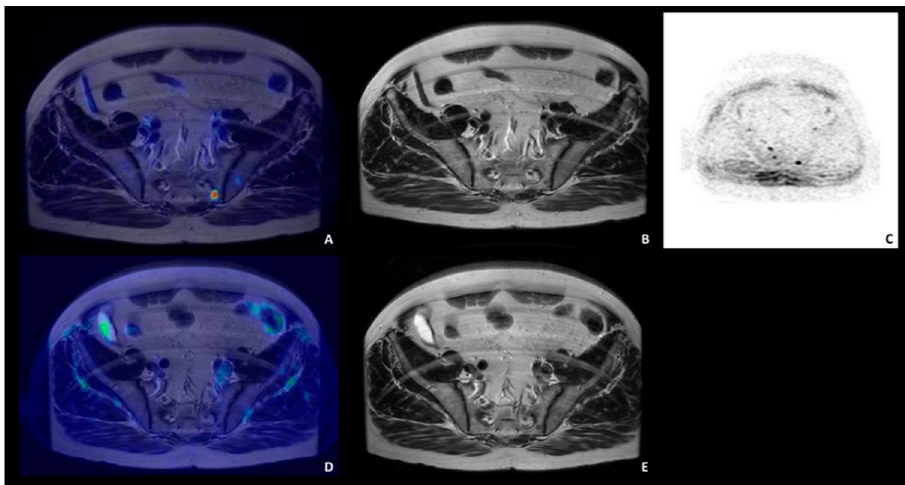
Figure 5. A 59 years-old patient with biopsy-proven PCa (patient n. 6), Gleason score 9 (4 + 5) with a PSA level at diagnosis of 11.0 ng/mL. 68 Ga-PSMA PET/MRI (top panel; ( A ): 68 Ga-PSMA PET/MRI; ( B ): axial T2-weighted sequence of the pelvis; ( C ): axial DWI (b = 1000) displayed with inverted greyscale map) showed increased uptake in correspondence of the left sacral ala, where MRI detected a bone metastasis; 68 Ga-DOTA-RM2 PET/MRI (bottom panel; ( D ): 68 Ga-DOTA-RM2 PET/MRI; ( E ): axial T2-weighted sequence of the pelvis) did not show any 68 Ga-DOTA-RM2 in correspondence of the bone metastases.